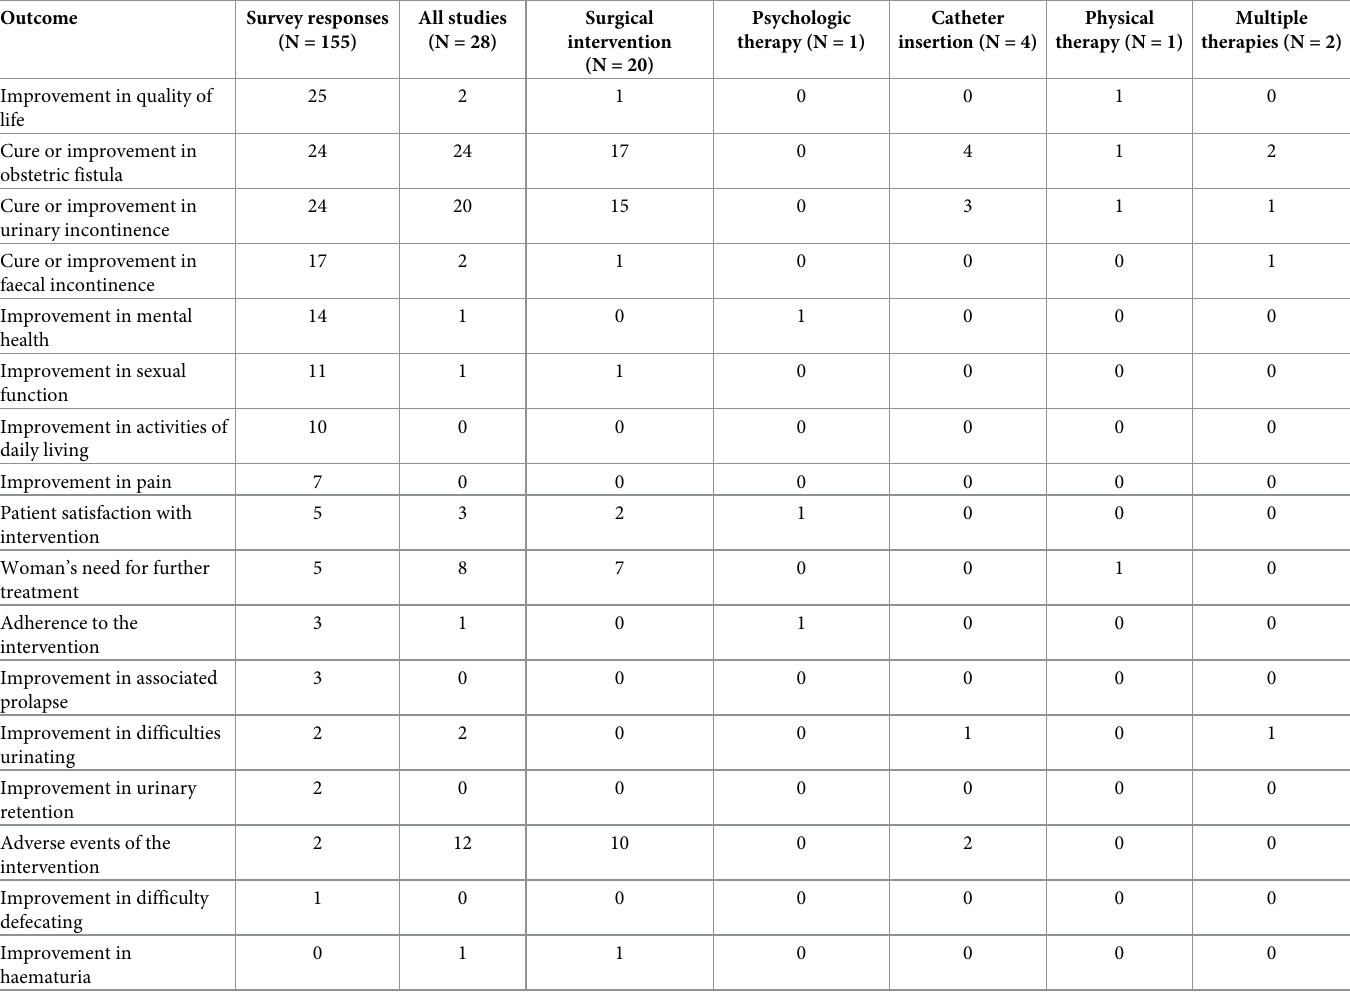
Table 6. Number of included studies reporting outcome